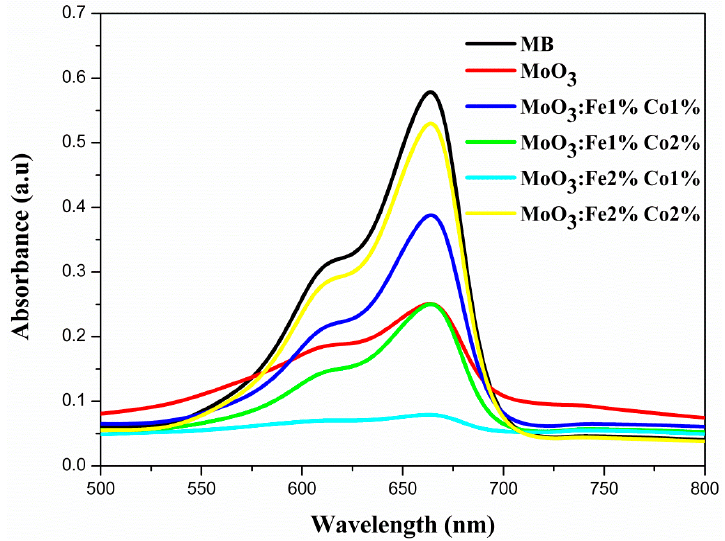
Figure 11. Absorption spectra of methylene blue (MB) solution under UV light after 1 h.